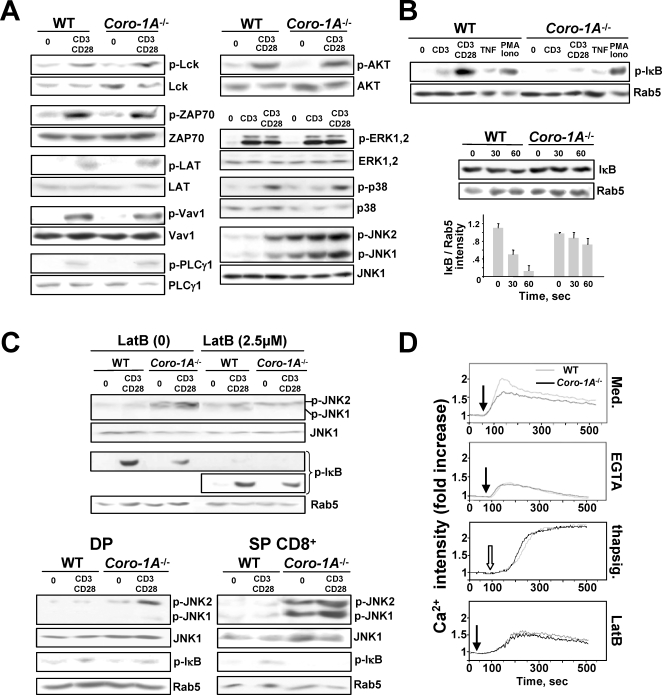
Signal Transduction in Coronin-1A-deficient T Cells.(A–C) Phosphorylation of the indicated signaling molecules was tested by Western blotting of protein lysates from thymocytes (5×106 cells) of WT or Coro-1A−/− mice using appropriate mAbs and the indicated stimulation conditions. Blots were reprobed for the non-phosphorylated protein, or for Rab5, as a loading control. (B) IκB degradation was assessed in total thymocytes activated with anti-CD3/-CD28 mAbs for 30 min. (C) Top panels: JNK or IκB phosphorylation in CD3/CD28-stimulated WT and Coro-1A−/− thymocytes pre-treated or not with LatB (0 or 2.5 µM); bottom panels: same analysis from purified DP and CD8+ SP thymocytes. All membrane exposures were for 2 min, except for the analysis of IκB phosphorylation following LatB treatment for which a longer exposure is also shown (20 min/middle panel of this experiment). (D) Analysis of Ca2+ responses using indo-1AM imaging and flow cytometry. Ca2+ measurements were performed using single cell fluorescence ratio of freshly isolated WT and Coro-1A
−/− thymocytes incubated in Ca2+-containing medium in the absence or presence of EGTA or LatB, then stimulated by the addition of an anti-CD3ε Ab (closed arrows) or thapsigargin (thapsig.; open arrow). Fluorescence emission at 526 nm was recorded at 30 sec intervals. The curve, in ‘fold increase’, represents the medium fluorescence intensity of an activated sample at a discrete time compared to that of the corresponding sample before activation (baseline value of 1). All data are representative from at least three experiments.